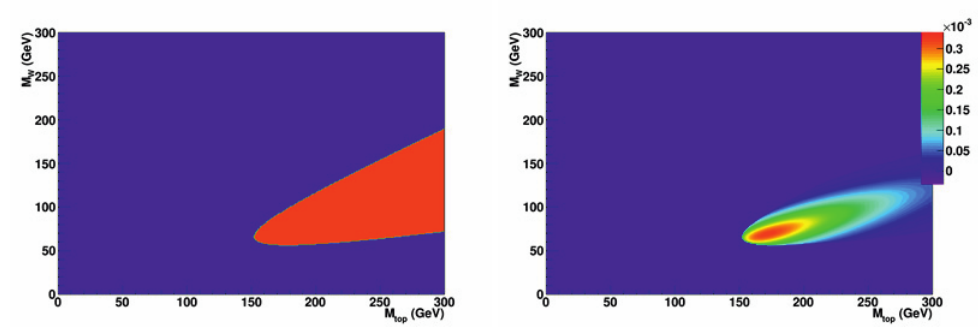
Figure 1. (Left): Solvability for the correct solution of a single top-pair event in the 2-dimensional mass plane. (Right): Solvability weighted with the PDFs and normalized to unit volume for the same solution and event.